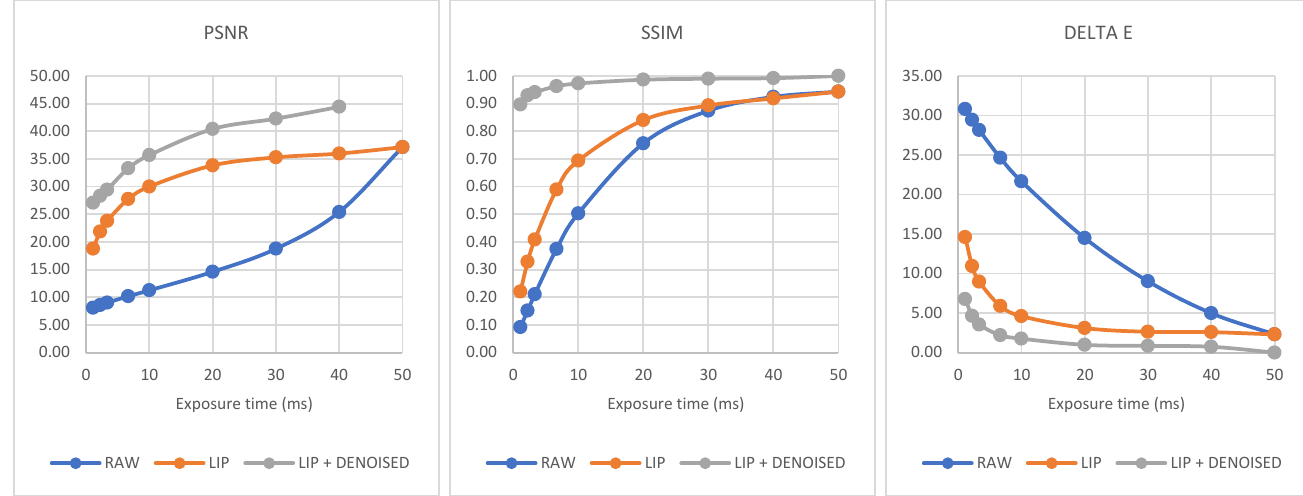
Figure 10. Evolution of PSNR, SSIM, and Delta E according to exposure time for each processing step (raw image, LIP enhancement, LIP + CNN denoising. For PSNR, LIP + denoised value is not represented for the clean target (50 ms) because it reaches infinity.